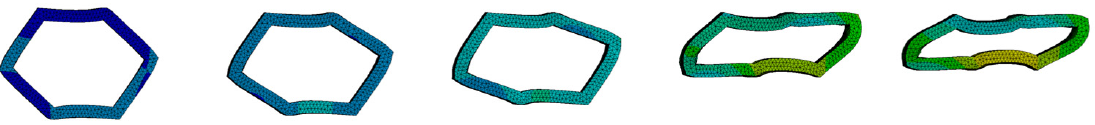
Figure 22. FE analysis of deformation process for the standard hexagonal cell under lateral load.